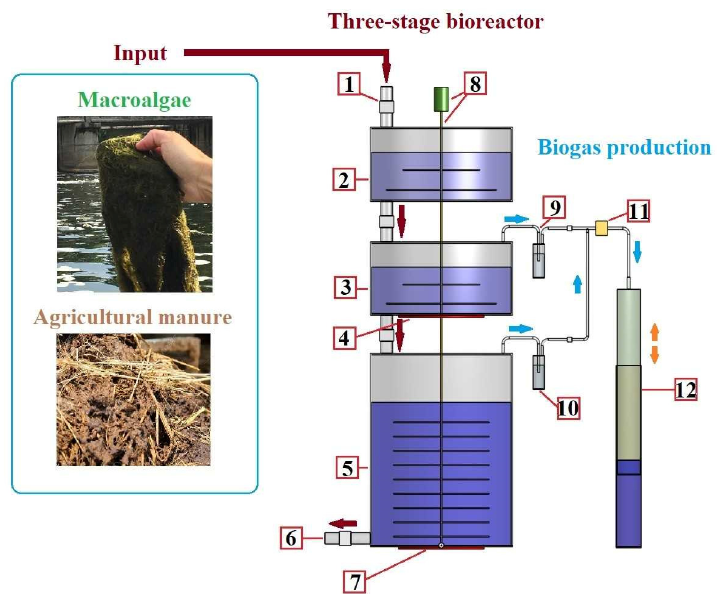
Figure 1. A three-stage bioreactor stand: 1—substrate supply pipe to the primary preparation chamber; 2—primary preparation chamber (PC-I); 3—secondary anaerobic chamber (AC-II); 4—AC-II heating elements; 5—tertiary anaerobic chamber (AC-III); 6—substrate outflow pipe; 7—AC-II heating elements; 8—mixer with motor; 9 AC-II biogas condenser; 10—AC-III biogas condenser; 11—shutter; and 12—biogas storage capacity.